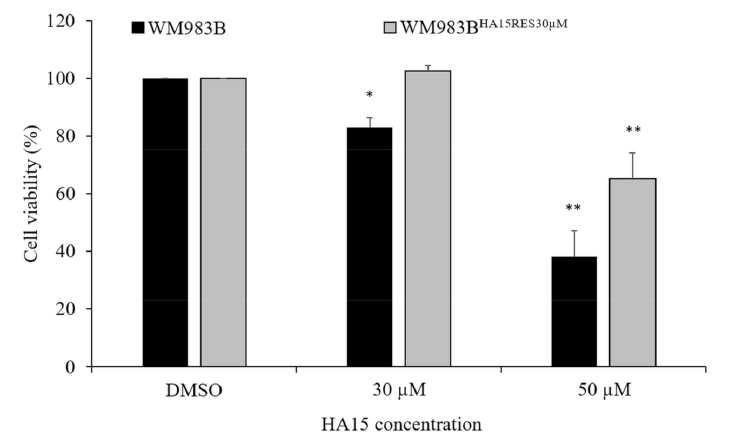
Figure 10. Viability of WM983B and WM983B HA15RES30 µ M melanoma cell lines. WM983B (black columns) and WM983B HA15RES30 µ M (grey columns) cell lines were treated with DMSO and 30 µ M and 50 µ M HA15 under normal culture conditions. Cell viability was measured after 48 h of drug treatment. Data are presented as the mean ± SD of three independent experiments. Significant differences are indicated by asterisks (* p ≤ 0.05; ** p ≤ 0.01).